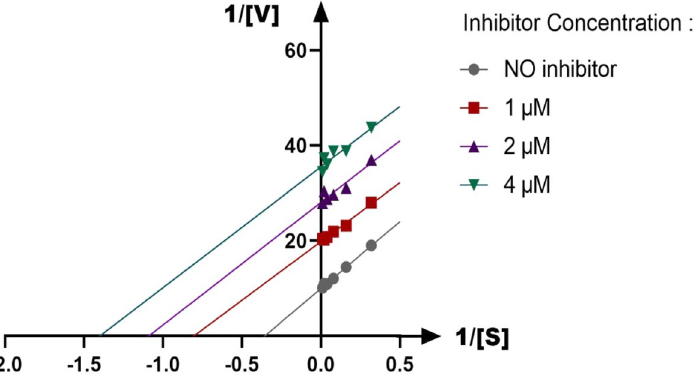
Figure 3. The Lineweaver–Burk plot of compound 8h at different concentrations against urease of three independent experiments.